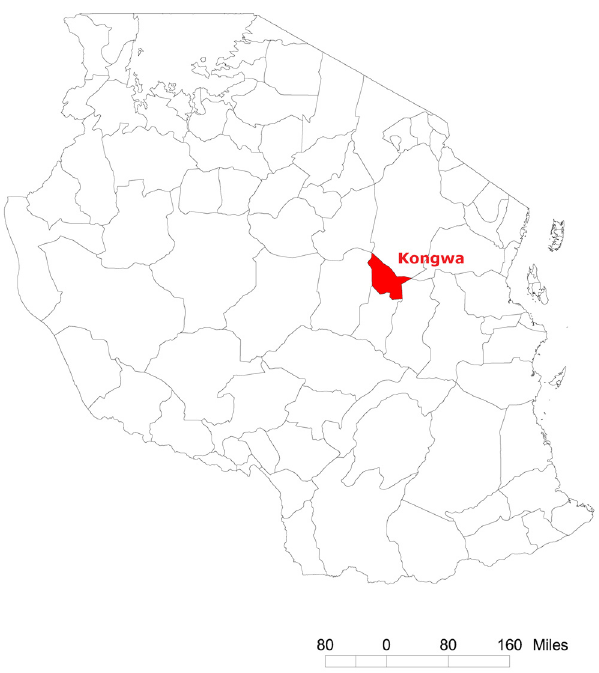
Figure 2. Location of Kongwa district in Tanzania.